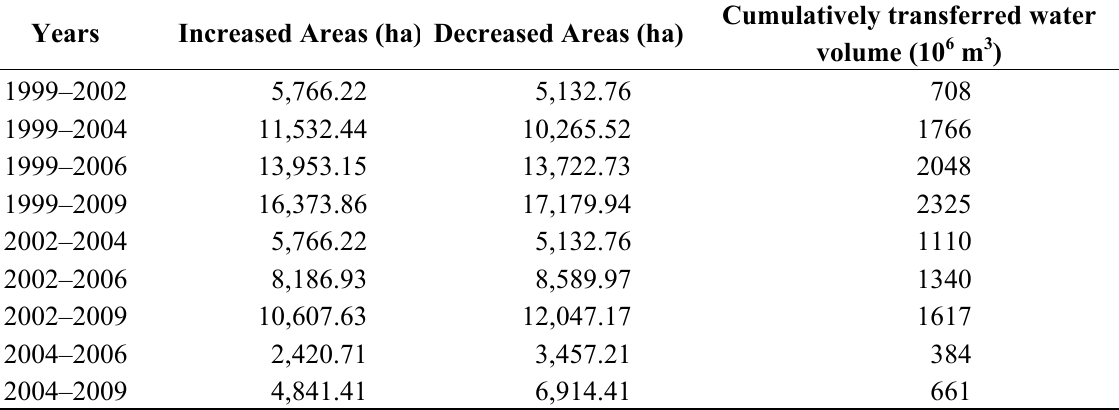
Table 4. Interpolation of change area and cumulatively transferred water volume. Bold numbers denote already existing data. The rest are derived from